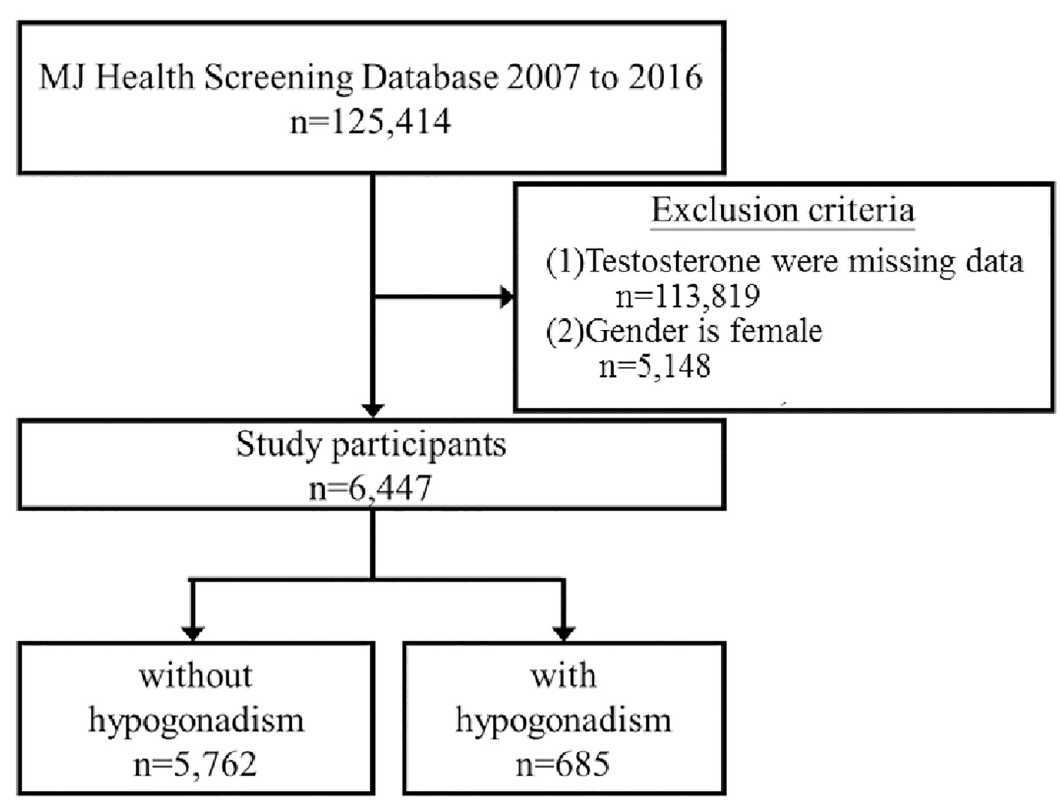
Fig 1. Flow diagram of participant